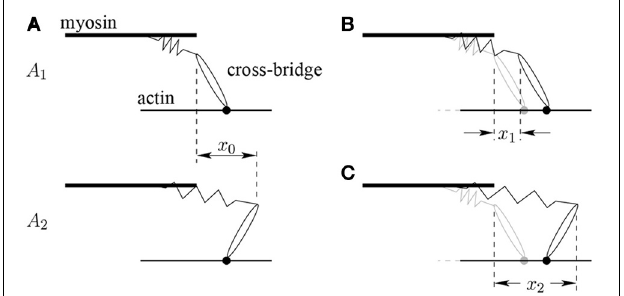
FIGURE 3 | (A) The average distortion x 0 induced through the power stroke in an isometric contraction. In the pre-power stroke state A 1 the cross-bridge is attached to the myosin binding site (small filled circle) and does not experience an elastic distortion. The power stroke converts the A 1 to the A 2 state by transducing chemically stored energy into mechanical energy, which is stored in the elastically distorted cross-bridges. (B) Average distortion x 1 induced through filament sliding during non-isometric contractions on the cross-bridges in the A 1 state. (C) Average distortion x 2 induced through filament sliding during non-isometric contractions on the cross-bridges in the A 2